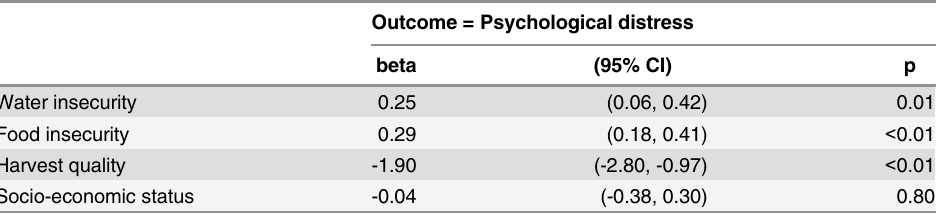
Table 5. Impact of selected variables on women ’ s psychological distress: Repeated-measures regres- sion with random-effect estimator (n =